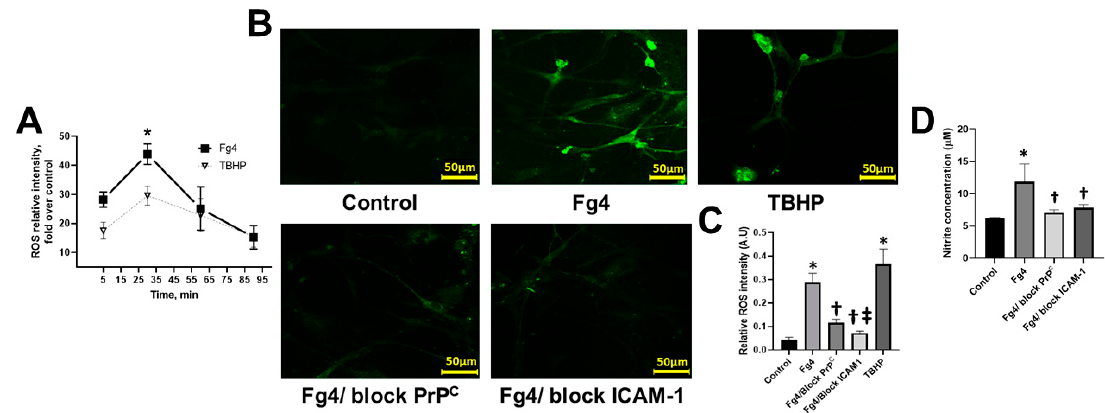
Figure 3. Fibrinogen (Fg)-induced generation of reactive oxygen species (ROS) and the production of nitric oxide (NO) in astrocytes. ( A ) The kinetics of astrocyte ROS formation induced by Fg was measured by luminol-enhanced chemiluminescence assay. Astrocytes were treated with 4 mg/mL of Fg (Fg4) or tert-butyl hydroperoxide (TBHP) used as a positive control. A two-way ANOVA test indicated that the effect of time and treatment on ROS production was significant with p < 0.0001 for both factors. p < 0.05; *—vs. time and treatment group; n = 4. ( B ) Representative images show ROS generation by astrocytes in response to treatment with medium alone (control), 4 mg/mL of Fg (Fg4), and 4 mg/mL of Fg in the presence of a function-blocking peptide against cellular prion protein (Fg4/block PrP C ) or 4 mg/mL of Fg in the presence of function-blocking antibody against intercellular adhesion molecule-1 (Fg4/block ICAM-1). TBHP was used as a positive control. ( C ) Summary of image analyses for the detection of Fg-induced ROS generation in astrocytes. p < 0.05 in all; *—vs. Control, †—vs. Fg-4 and ‡—vs. Fg4/block PrP C ; n = 6. ( D ) Production of astrocyte NO in response to Fg treatment was assessed by measuring NO content in astrocyte media after experiments using a Griess reaction assay. Cells were treated with medium alone (control), 4 mg of Fg, 4 mg/mL of Fg in the presence of a function-blocking peptide against PrP C (Fg4/block PrP C ), and 4 mg of Fg in the presence of a function-blocking antibody against ICAM-1 (Fg4/block ICAM-1). p < 0.05 in all; *—vs. Control, n = 4.